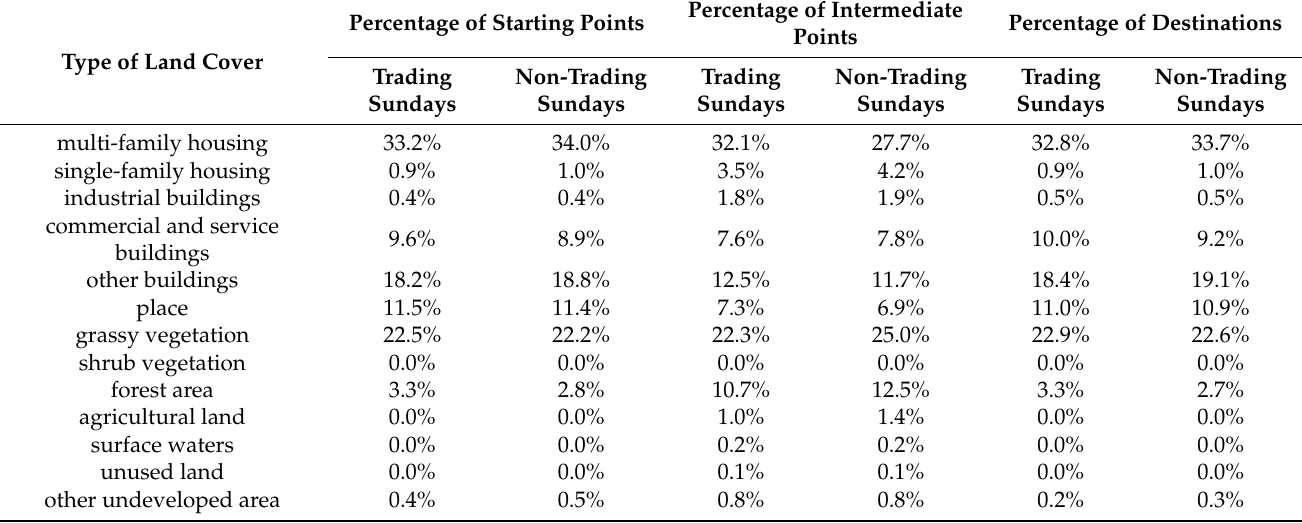
Table 4. The structure of distribution of characteristic points for trips taken by the ŁPB users against the type of land cover in Ł ó d´z in the cycling season of